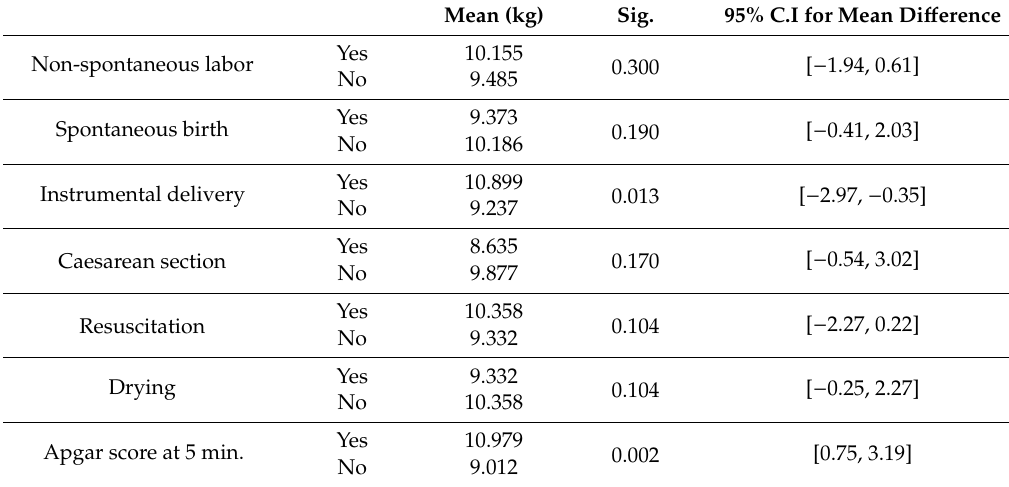
Table 4. Student’s t-test results for weight gain vs. intrapartum and neonatal outcomes. Mean (kg)